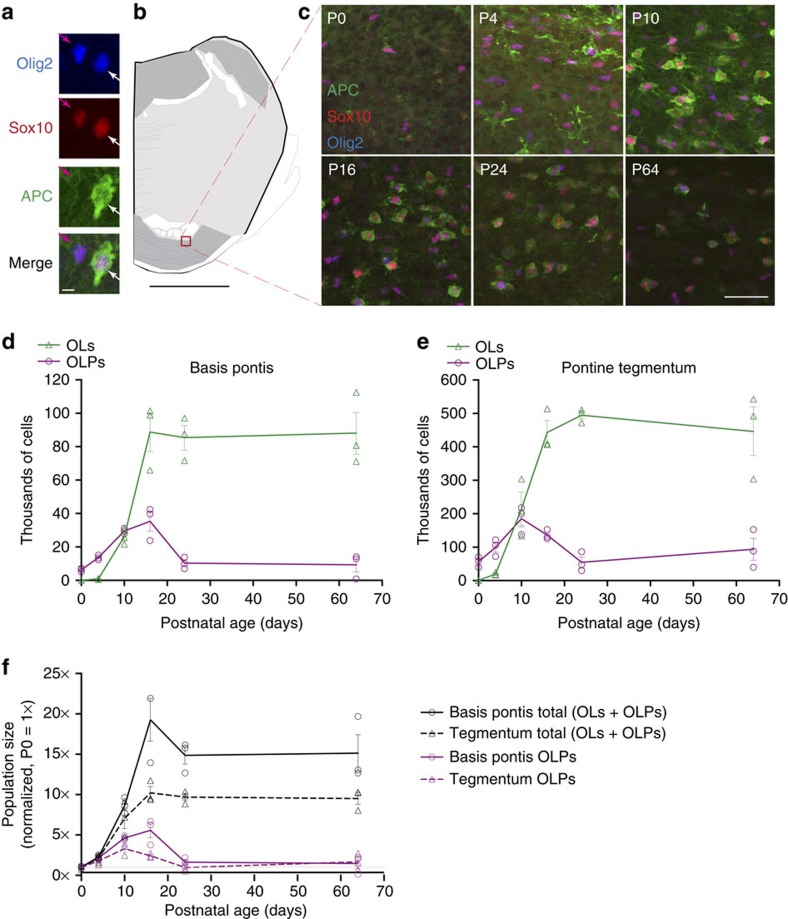
Expansion and maturation of OL lineage in postnatal pons.CD1 wild-type mouse pons sections were stained for Sox10, Olig2 and APC. (a) Representative OLP (Olig2+Sox10+APC−, magenta arrow) and OL (Olig2+Sox10+APC+, white arrow) from P10 mouse basis pontis. Scale bar, 5 μm. (b) Schematic of basis pontis region shown at several ages in (c). Scale bar, 1 mm. (c) Age series from basis pontis shows postnatal changes in density and maturation state of OLPs and OLs. Note sequential upregulation, condensation, and diminution of APC over time. Scale bar, 50 μm. (d,e) Stereologic counts of pons oligodendroglia in basis pontis (d) and tegmentum (e) over postnatal development, measured by Optical Fractionator probe in StereoInvestigator software. Cells were identified as OLs if they expressed APC and either or both of Sox10/Olig2; cells were counted as OLPs if they expressed both Sox10 and Olig2 but not APC. (f) Counts of OLPs (purple) and total oligodendroglia (OLs+OLPs, black) were normalized to P0 values, revealing fold expansion of the oligodendroglial population since P0 (1 ×). All graphs show individual replicates with mean±s.e.m. of n=3 mice per timepoint.